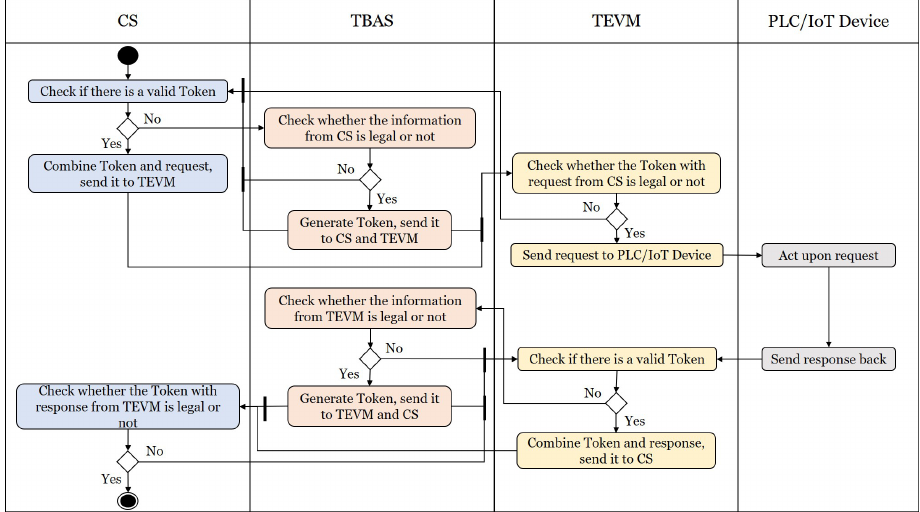
Figure 3. The authentication